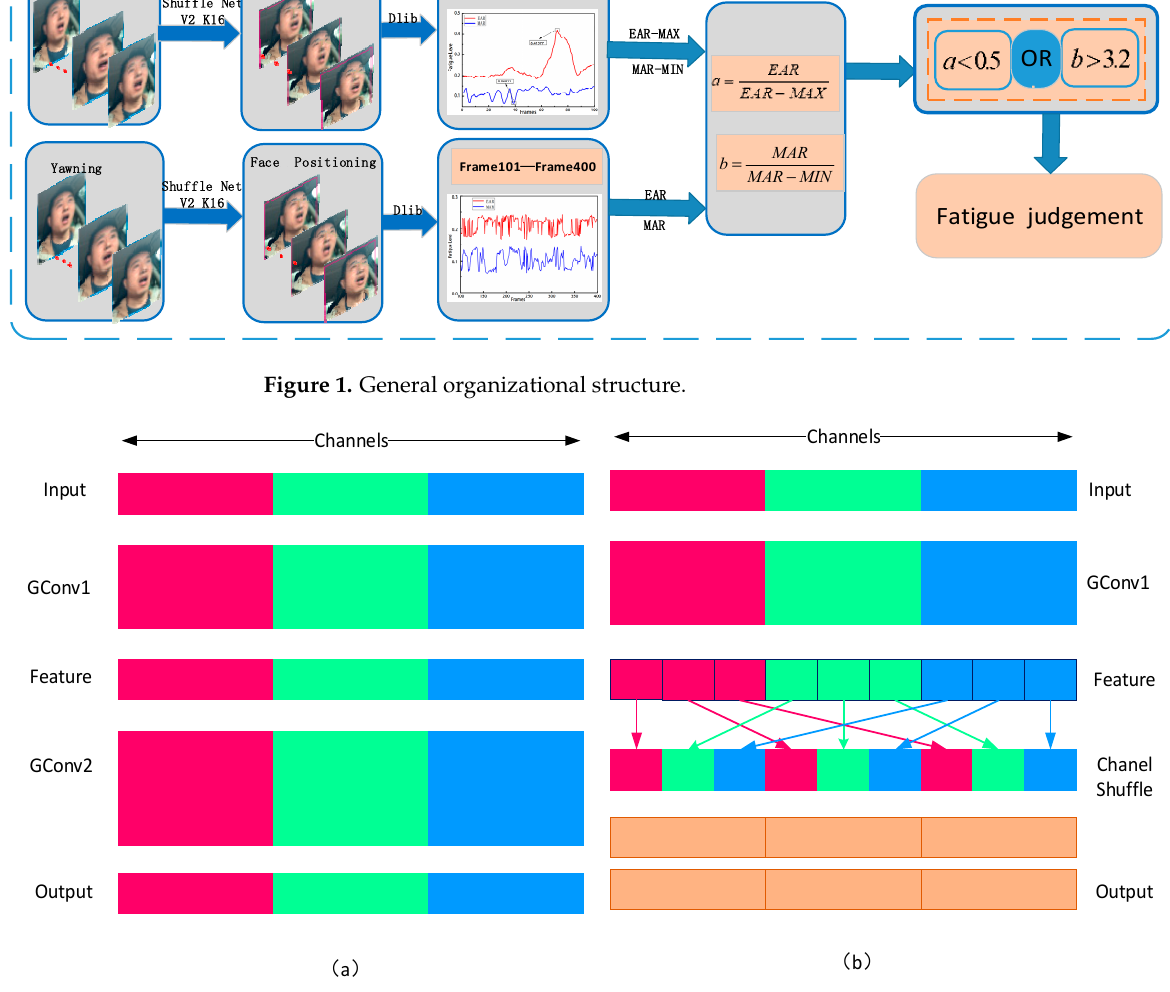
Figure 2. Structural characteristics diagram.(a) two stacked convolution layers with the same num- ber of groups.(b)input and output channels and fully related when GConv2 takes data from differ- ent groups after